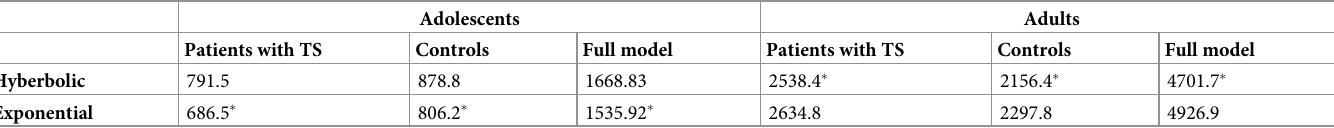
Table 2. Model comparison of two variants of intertemporal choice.